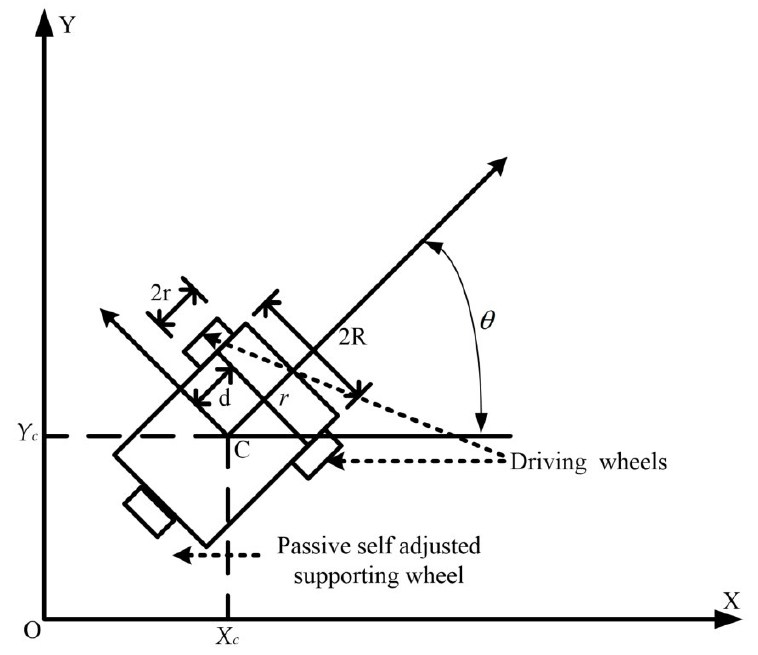
Figure 1. The wheeled mobile robot model.